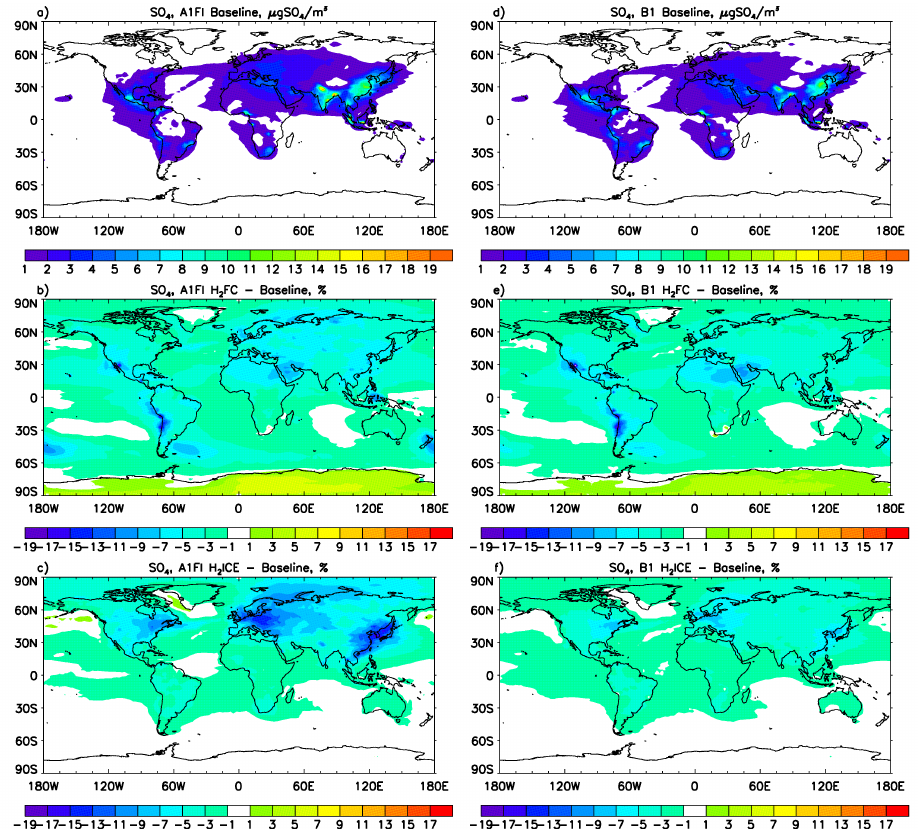
Figure 15. CAM-Chem simulated 2050 annual mean surface SO 4 concentrations in the A1FI (a) and B1 (d) baseline scenarios and percent differences for the H 2 fuel cell (H 2 -FC) and H 2 internal combustion engine (H 2 -ICE) scenarios (b, c, e, f) . Note the different scales.